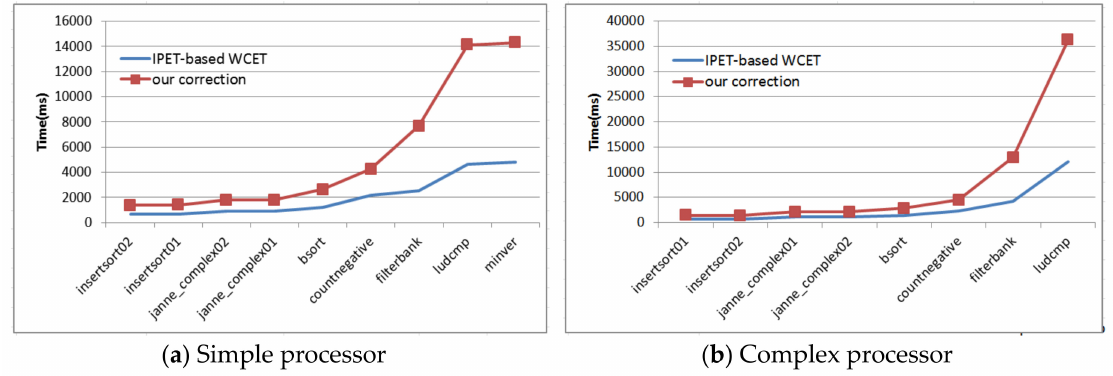
Figure 9. The comparisons of time overhead.